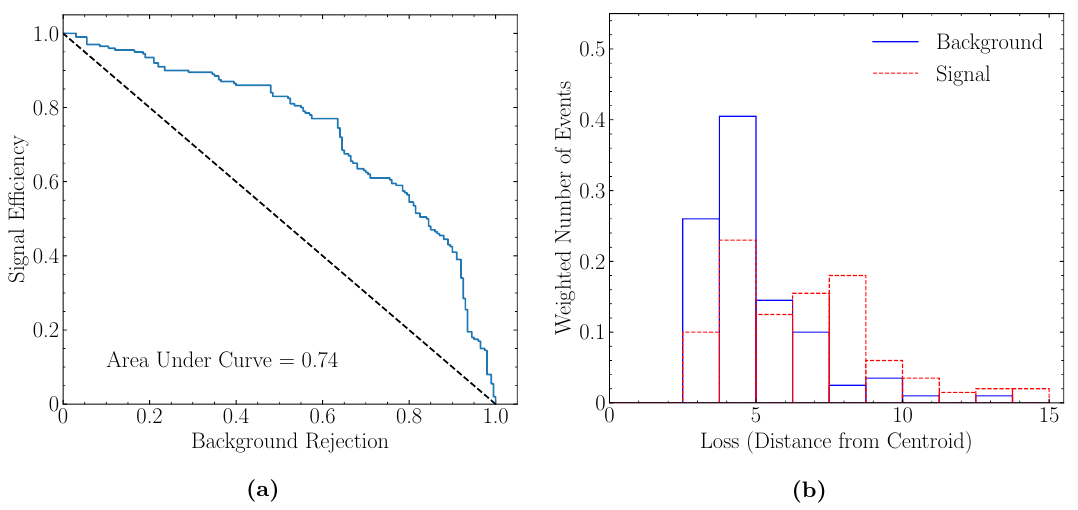
Figure 4. (a) shows the ROC curve for K-means anomaly detection method trained on classically constructed feature vectors. The distribution of the loss for the signal and background test sets is shown in